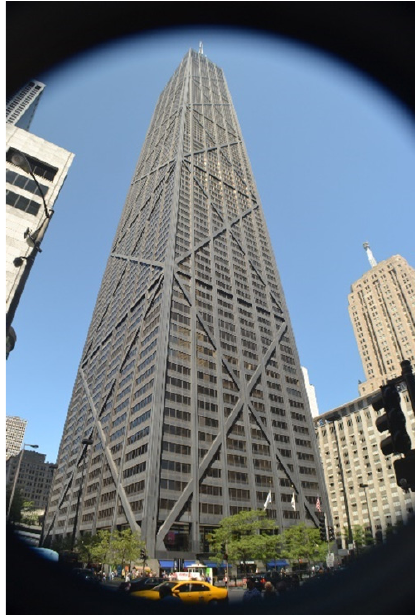
Figure 8. Braced Tube building, the John Hancock Center (1970) in Chicago. (Photo by K. Al-Kodmany).